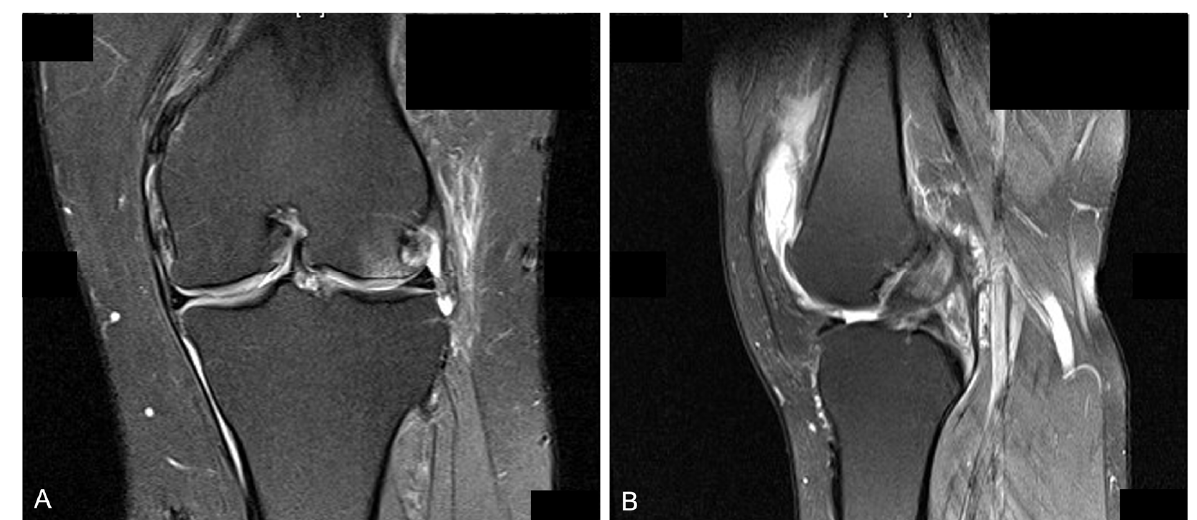
Figure 2. Preop MRI: ( A ) under T2-weighted image, coronal view showed lateral meniscus tear, lateral compartment cartilage disruption, and subchondral bone edema; ( B ) under T2-weighted image, sagittal view showed intact anterior cruciate ligament.